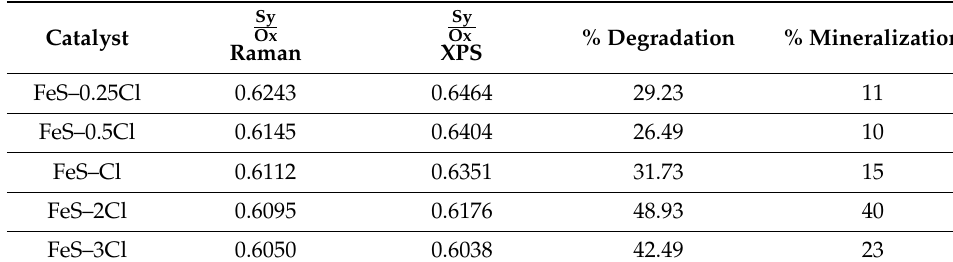
Figure 17. Fe 2+ temperature reduction vs. degradation and mineralization percentage.